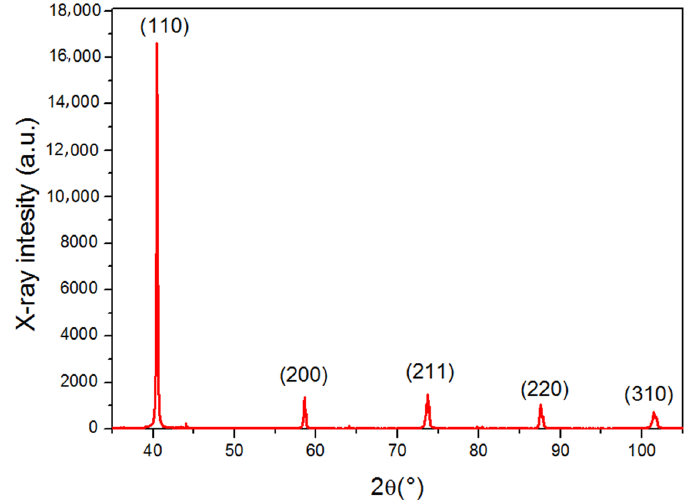
Figure 2. The XRD pattern of the examined Mo.